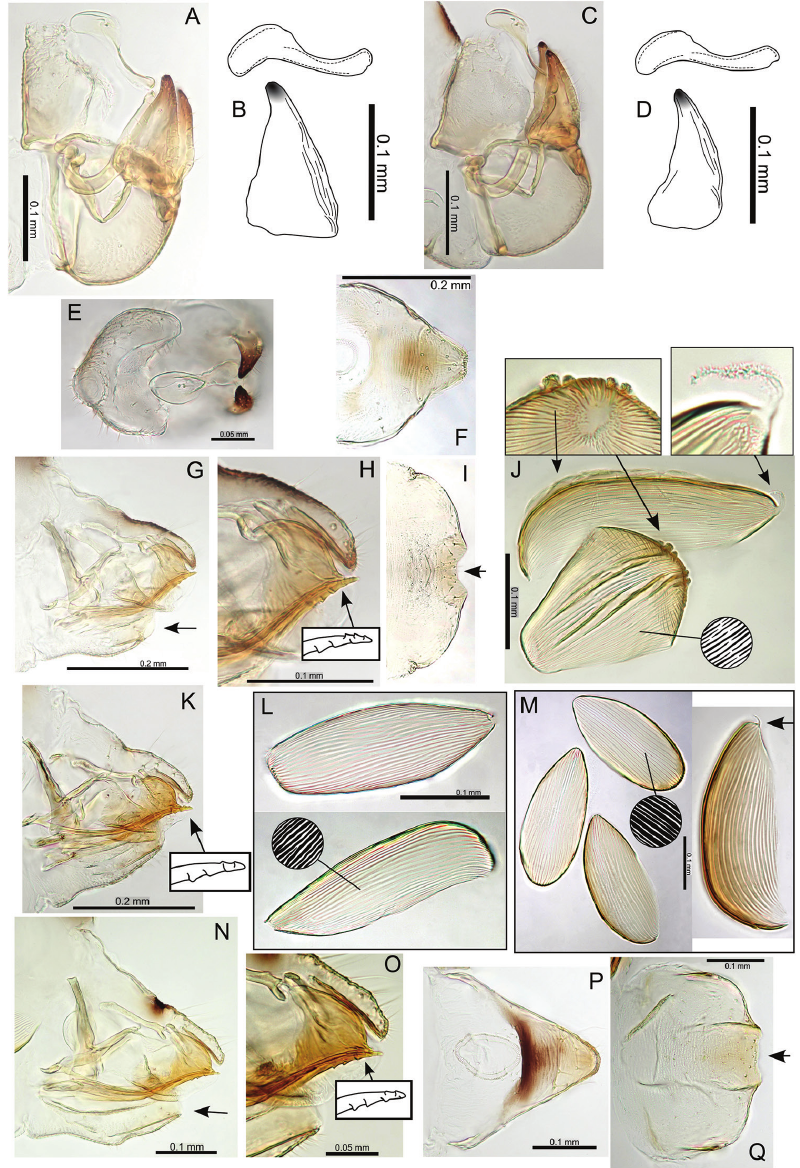
Figure 7. Pariaconus hina sp. n. A, B, male terminalia, aedeagus and paramere, form ovostriatus C, D male terminalia, aedeagus and paramere, form occidentalis E, F, G, H, I, J form ovostriatus : E male terminalia (dorsal view) F female proctiger (dorsal view) G female terminalia (truncate subgenital plate indicated) H ovipositor (serrations indicated) I female subgenital plate (ventral view, concave apex in- dicated) J eggs (tail and striations indicated) K, L form occidentalis : K female terminalia (ovipositor serrations indicated) L eggs (striations indicated) M, N, O, P, Q form orientalis : M female terminalia (truncate subgenital plate indicated) O ovipositor (serrations indicated) P female proctiger (dorsal view) Q female subgenital plate (ventral view, concave apex